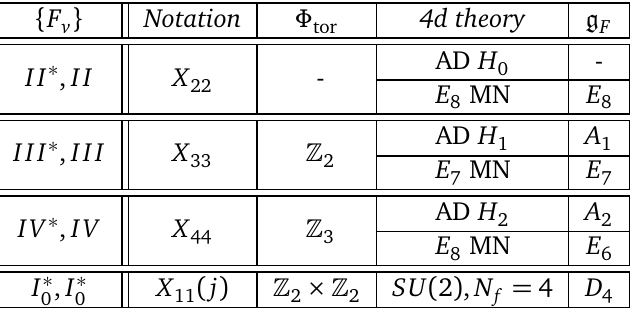
Table 6: Extremal rational elliptic surfaces without multiplicative ( i.e. I